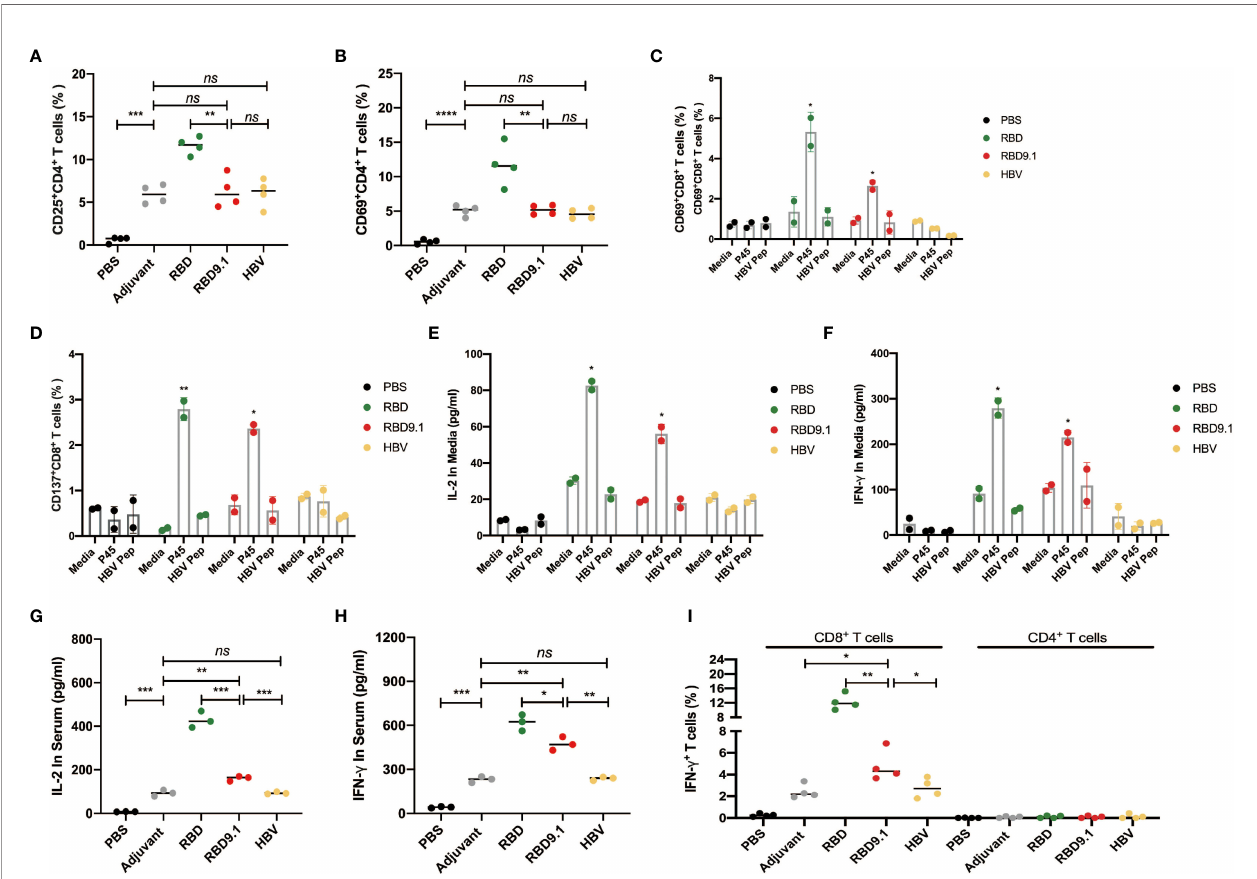
FIGURE 4 | RBD9.1 induced CD4+ and S448-456-speci fi c CD8+ T-cell immune responses. (A) The expressions of CD25 and CD69 (B) (gated on CD4 + T cells) were detected by fl ow cytometry on the seventh day after the last immunization. (C) The expressions of CD137 and CD69 (D) (gated on CD8 + T cells of immune mice) were detected by fl ow cytometry after 10 m g/ml P45 (S 448-456 ) or HBV peptide stimulation for 24 h; normal media was used as negative control. (E) The quantities of interleukin (IL)-2 and interferon (IFN)- g (F) in the supernatant were detected by ELISA after 10 m g/ml P45 ( S 448-456 ) or HBV peptide stimulation for 48 h; media or HBV peptide was used as the corresponding negative control. (G) IL-2 and IFN- g (H) in the immunized serum were detected by ELISA on the 10th day after the last immunization. The expression of IFN- g (gated on CD4 + or CD8 + T cells) was detected by fl ow cytometry on the 10th day after the last immunization. * P < 0.05, ** P < 0.01, *** P < 0.001, **** P < 0.0001; ns, non-signi fi